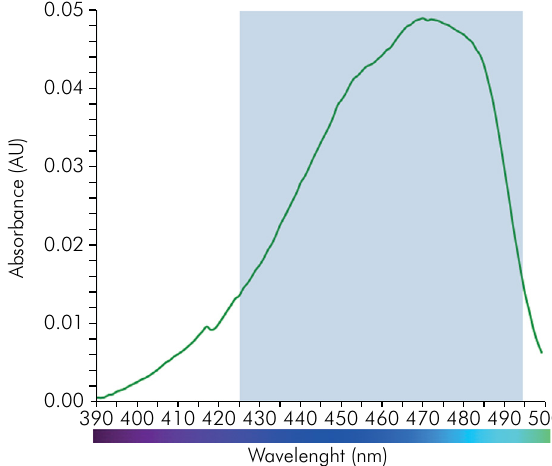
Figure 9. Visible light absorption of the photoinitiator, Lucirin® TPO, spanning from about 390 to 410